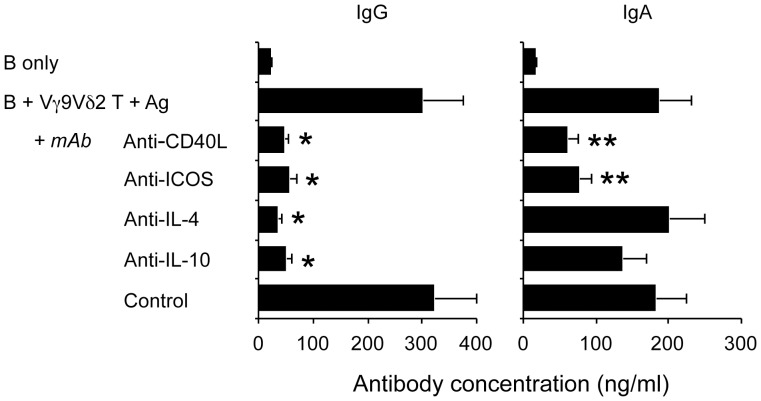
Vγ9Vδ2 TFH cell helper activity requires costimulatory molecules and cytokines.Vγ9Vδ2 T cells were cultured with an equal number of irradiated DCs and IPP, in the presence of IL-21. At the end of culture, Vγ9Vδ2 TFH cells were sorted and cultured with CD19 B cells isolated from the tonsil of the same donor, in the presence of IPP and mAbs to costimulatory molecules or cytokines (see Materials and Methods). Ten days later, total IgG and IgA levels in culture supernatants were assessed by ELISA. *p<0.005 and **p<0.02 when compared with the group consisting of B cells cultured with Vγ9Vδ2 TFH cells and antigen. One out of five independent experiments is shown.